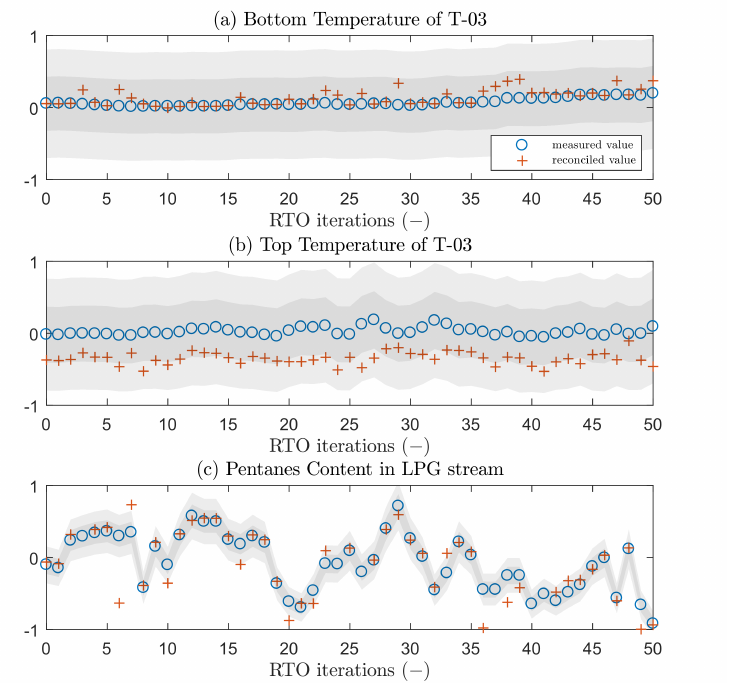
Figure 6. Data reconciliation results: ( a ) bottom temperature of T-03; ( b ) top temperature of T-03; ( c ) pentanes content in LPG